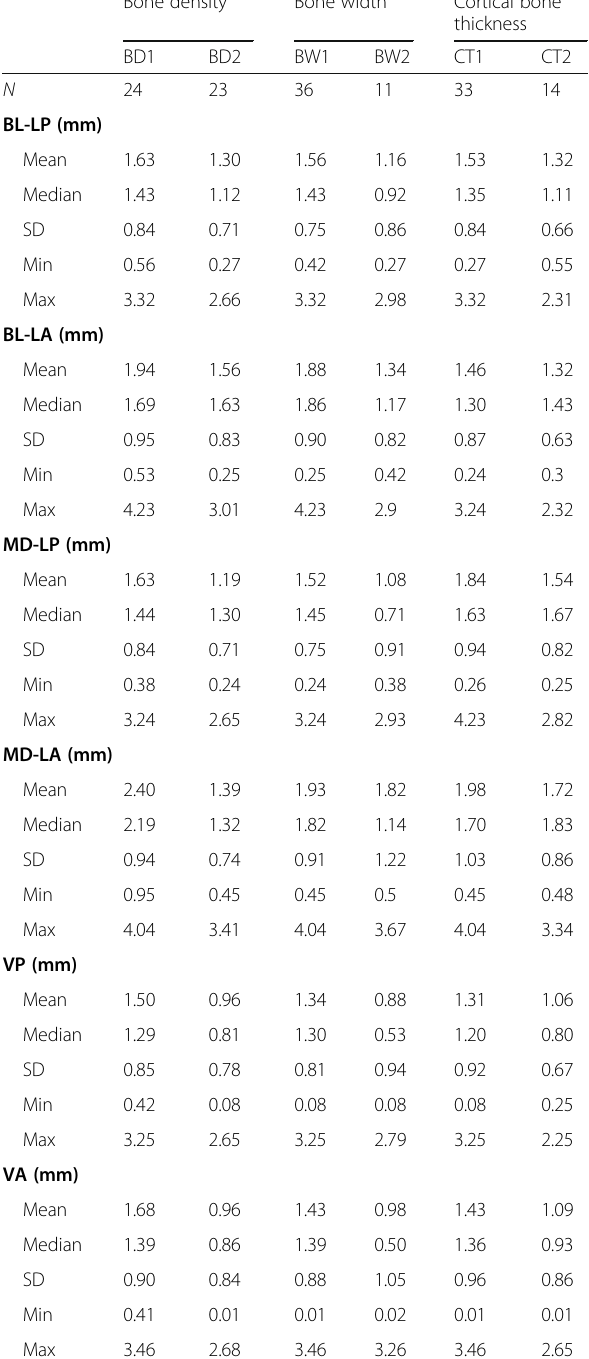
Table 3 Descriptive statistics of implant placement accuracy parameters on each bone condition